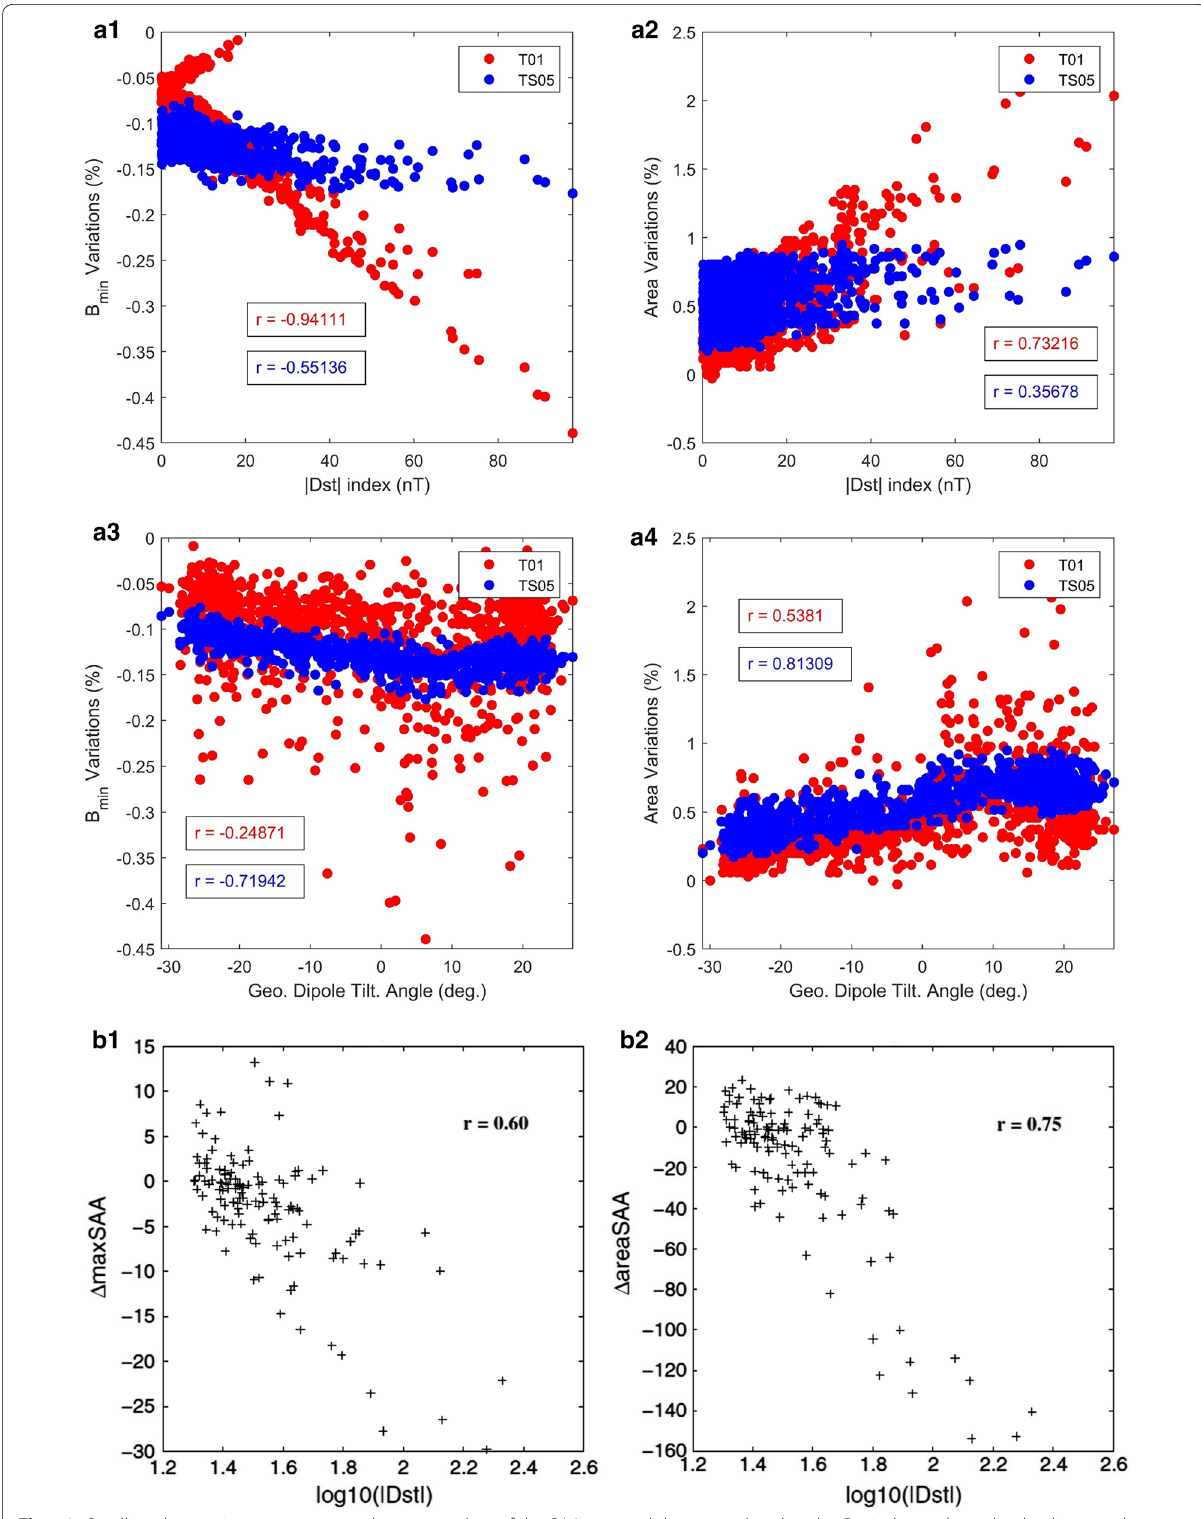
Fig. 13 Satellite observations. a represents the scatter plots of the SAA B min and the area, related to the Dst index and geodipole tilting angle, as computed from Tsyganenko models T01 and TS05, at 800 km. b represents the scatter plots of (cid:31) maxSAA and (cid:31) areaSAA , corresponding to the maximum flux values and the SAA proton flux area, respectively, with respect to the Dst index, as measured from NOAA 17 (Zou et al.